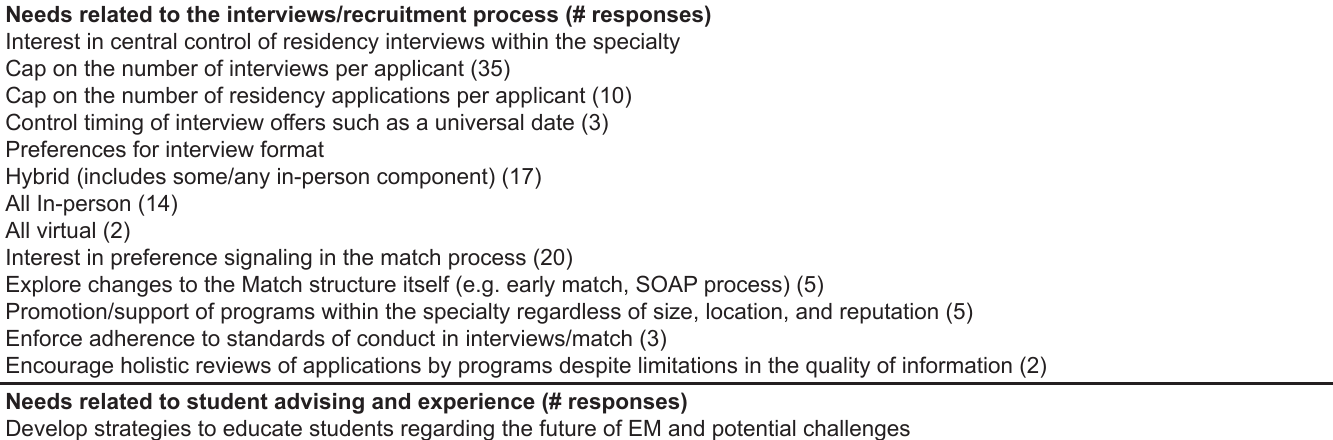
Table 2. Thematic summary of free-text responses for program needs. This table represents themes identified in the free-text answers to program needs from CORD after the 2022 EM Match. The number in parentheses indicates the number of respondents who mentioned that